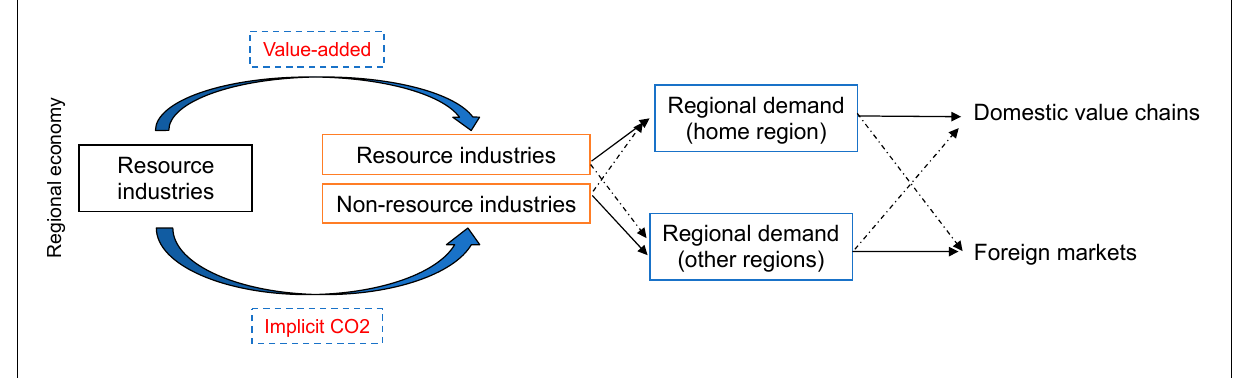
Figure 2. Empirical strategy scheme.